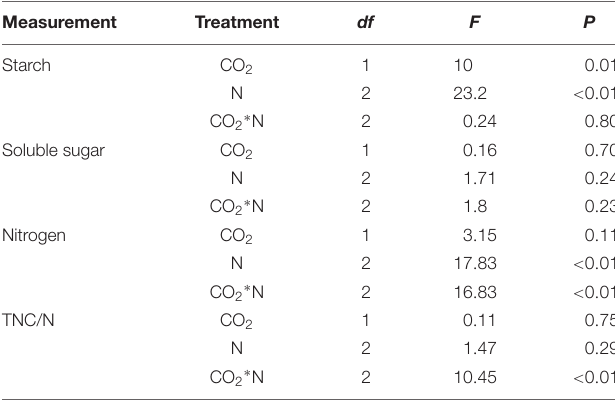
TABLE 2 | Summary of ANOVA results for effects of elevated CO 2 and increased nitrogen fertilization on chemical components of maize.